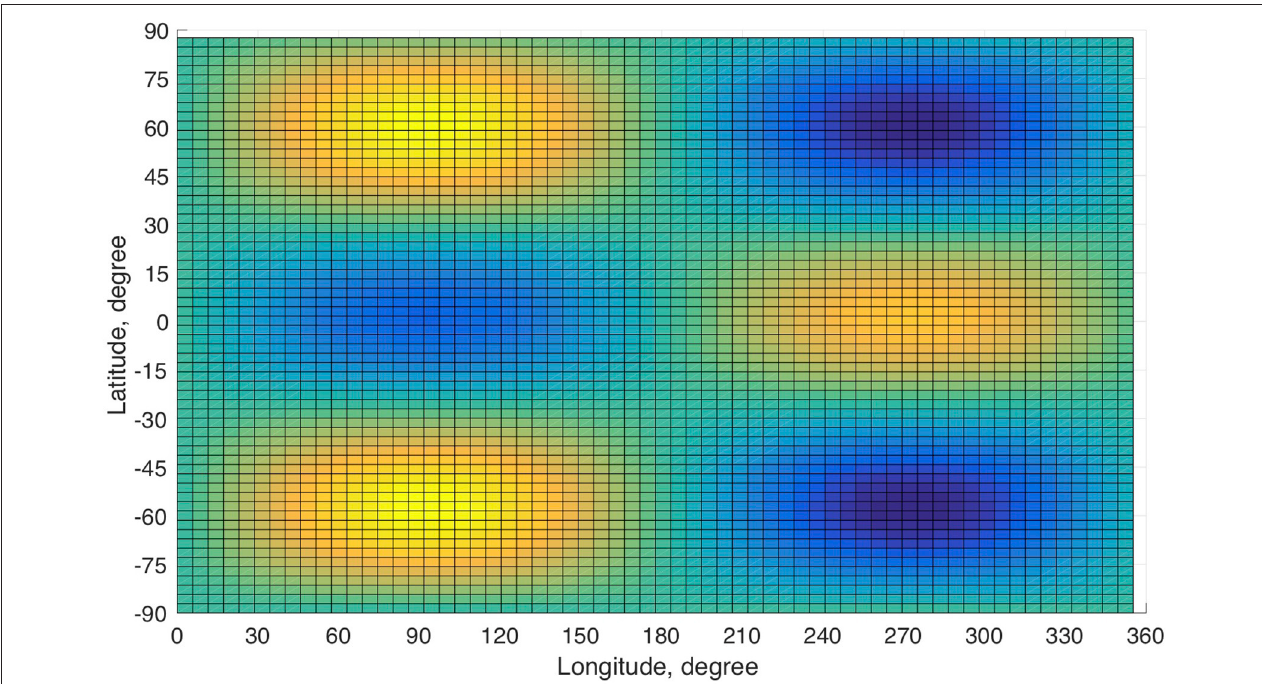
FIGURE 3 | Spatial structure of spherical magneto-Rossby waves. Here the poloidal velocity of m